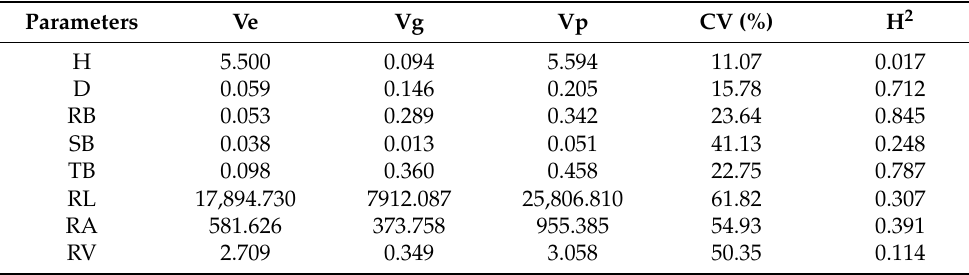
Table 6. Variances and broad-sense heritability of seedling parameters in X. sorbifolium .